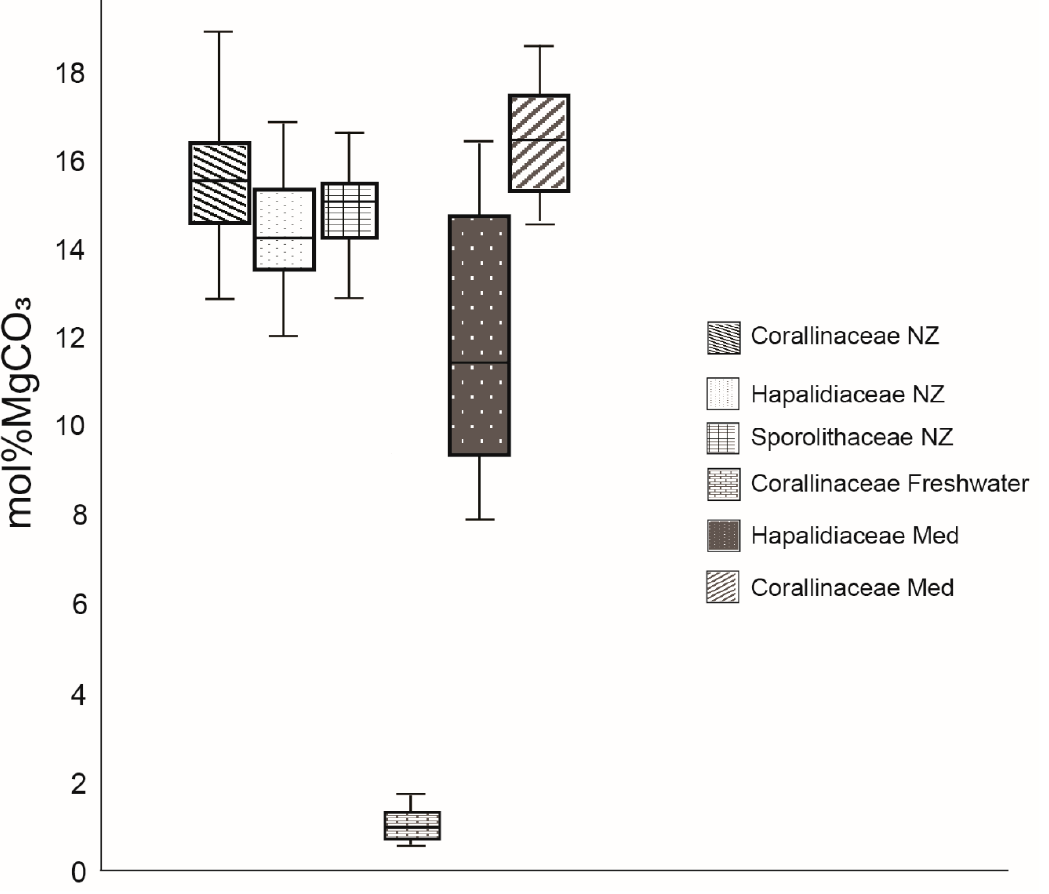
Figure 4. mol% MgCO 3 of marine coralline algae from different families and regions (New Zealand (NZ) and Mediterranean Sea (Med)) and the freshwater algae Pneophyllum cetinaensis. Data of the seawater coralline algae were collected from: [17,37,38].